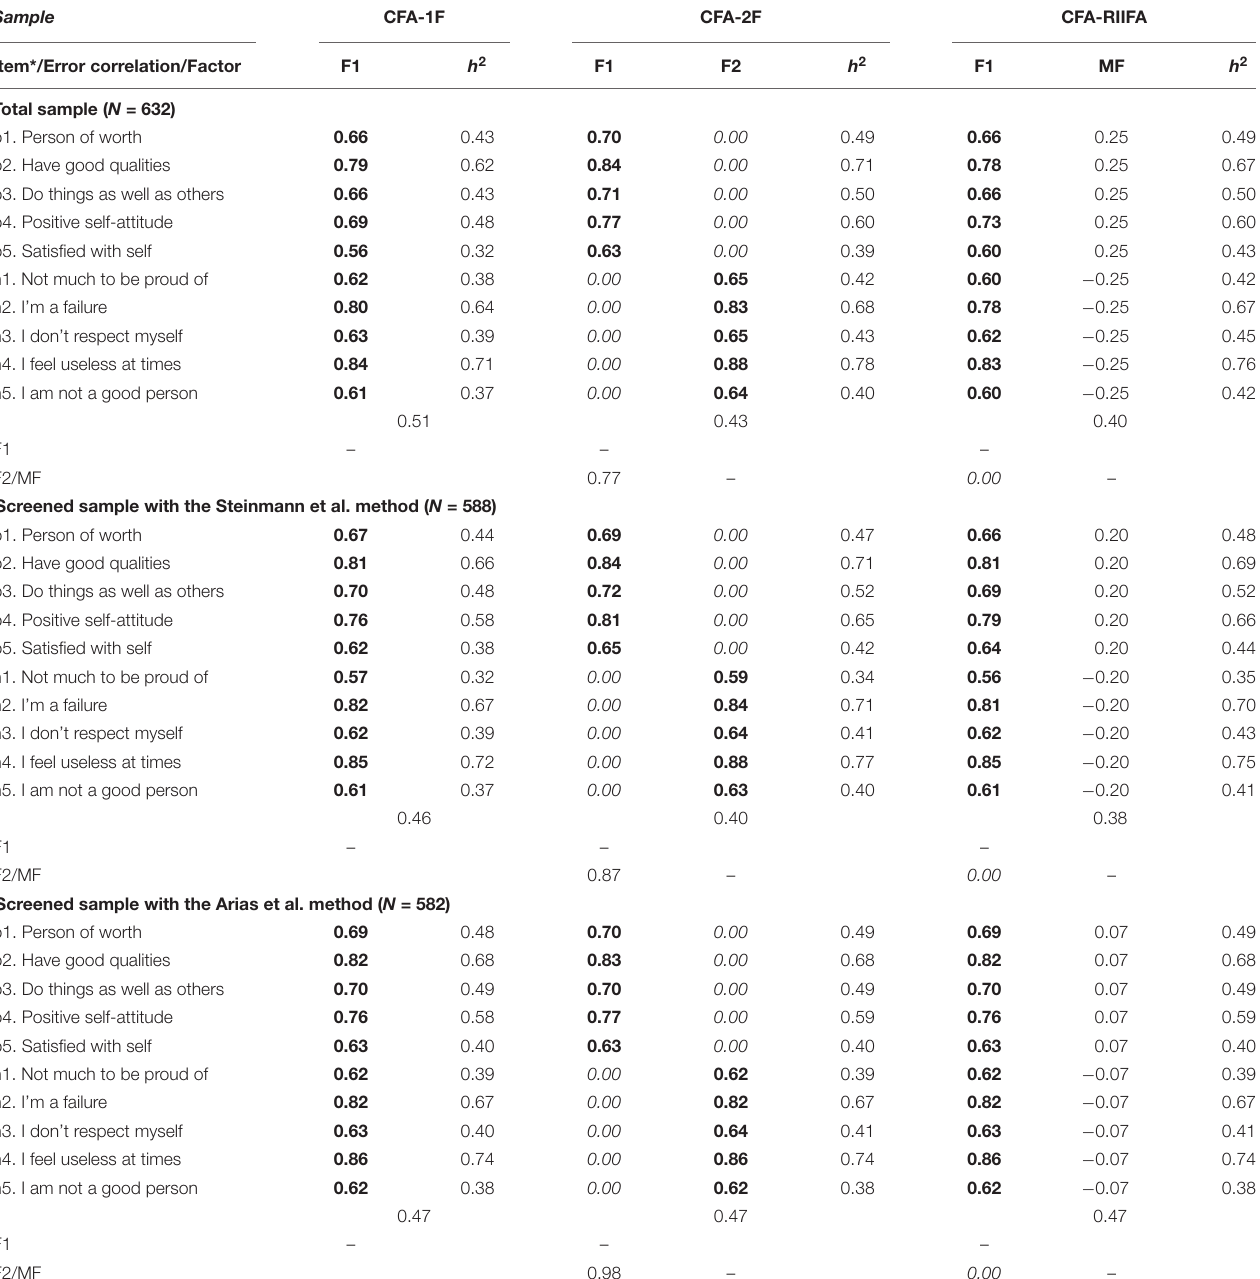
TABLE 3 | Factorial loadings, error correlations, and factor correlations for the RSES models. Sample CFA-1F CFA-2F